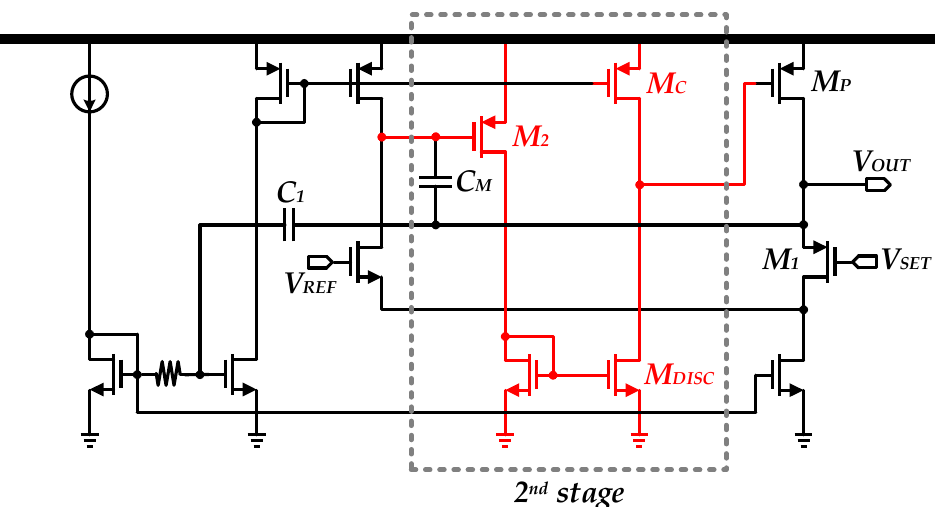
Figure 6. Structure of an LDO regulator based on a loop-gain-enhanced FVF [15].